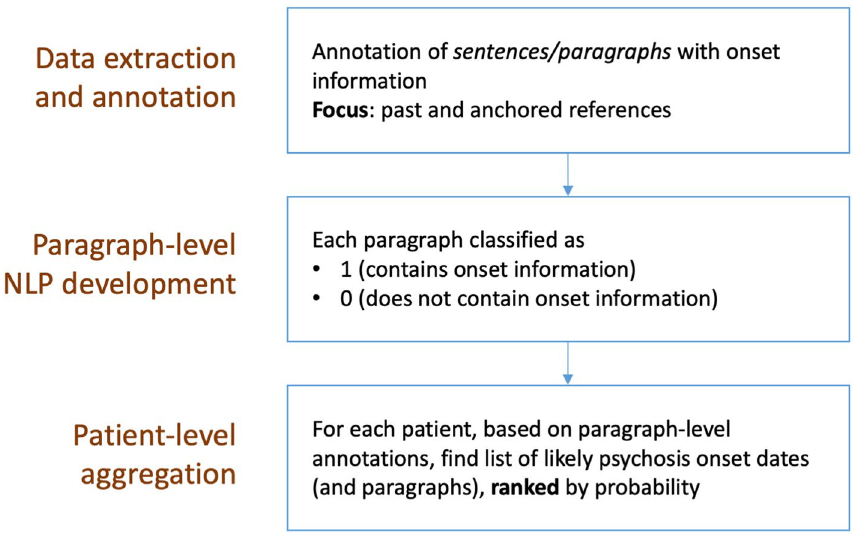
Figure 2. Main NLP development steps for determining onset information in mental health text: manual annotation, paragraph-level classification, and patient-level date ranking.